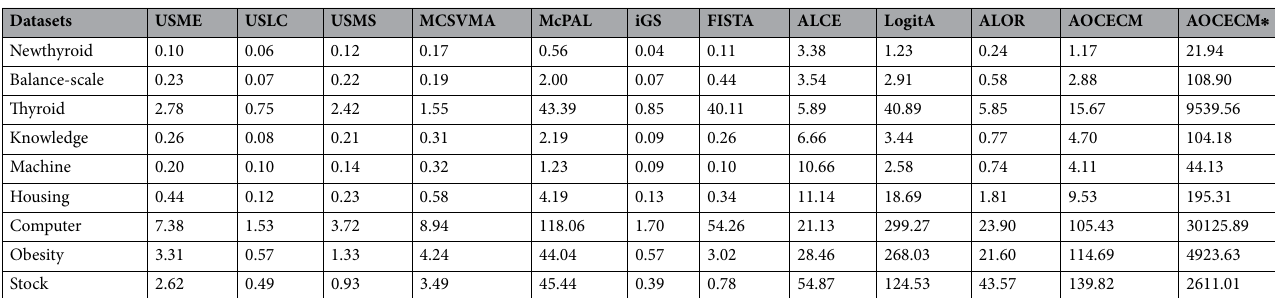
Table 5. Execution time (second) of different